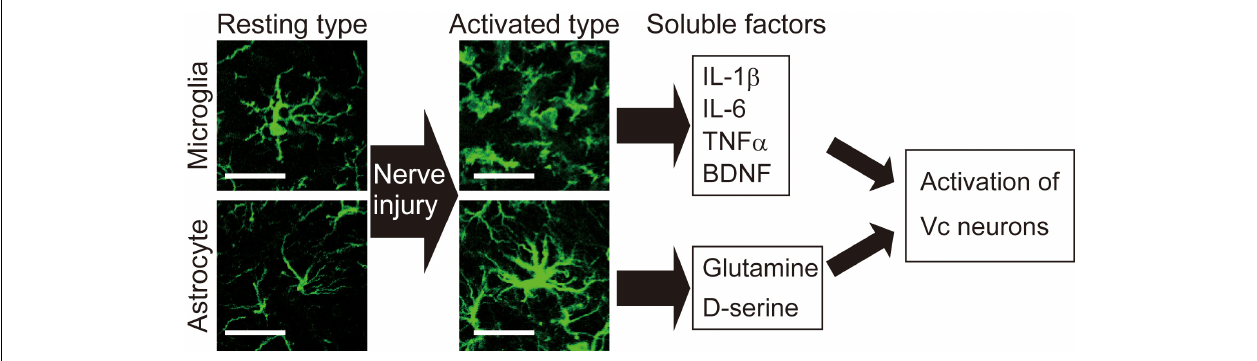
FIGURE 2 | Activation of microglia and astrocytes is observed in the Vc following peripheral nerve injury. Images show microglia and astrocytes in the Vc of normal rat or rat with infraorbital nerve injury (IONI). In the physiological situation, both microglia and astrocytes exhibit highly branched and thin processes, which is called resting type. Seven days after IONI, hypertrophic morphology of microglia and astrocytes, which is called activated type, is observed in the Vc. Activated types of glial cells release multiple factors that enhance neuronal activity in the Vc. Scale bar: 50 µ